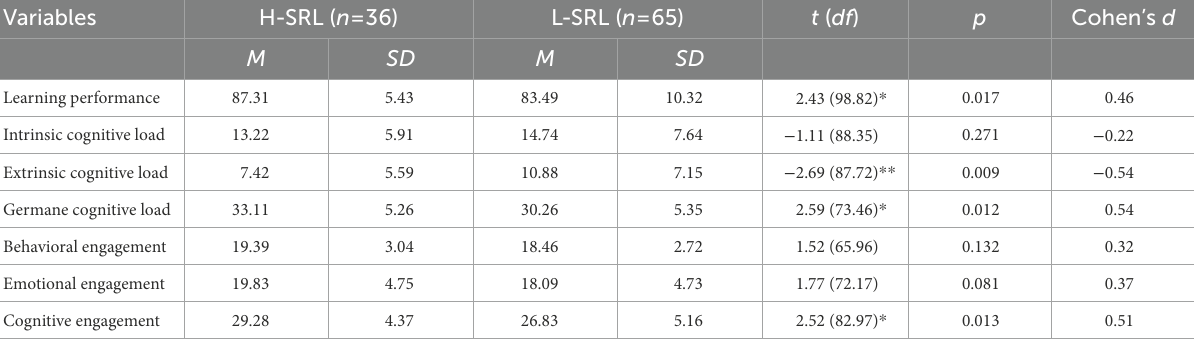
TABLE 2 The results of Welch’s independent t tests on learning performance, cognitive load, and student engagement between the two groups. Variables